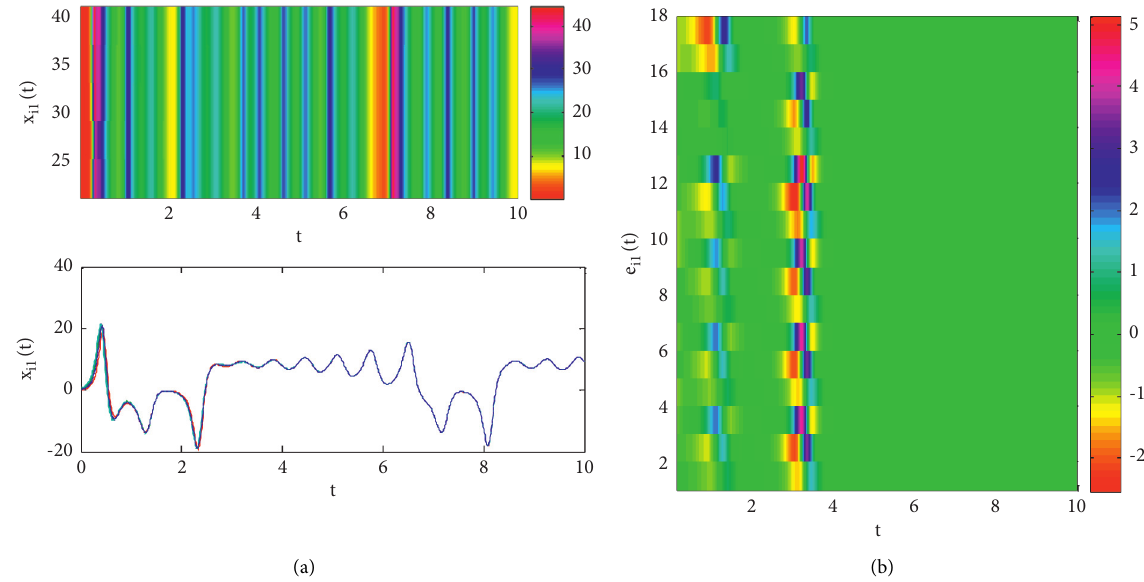
Figure 6: The evolution of state variables in the first area and the synchronization